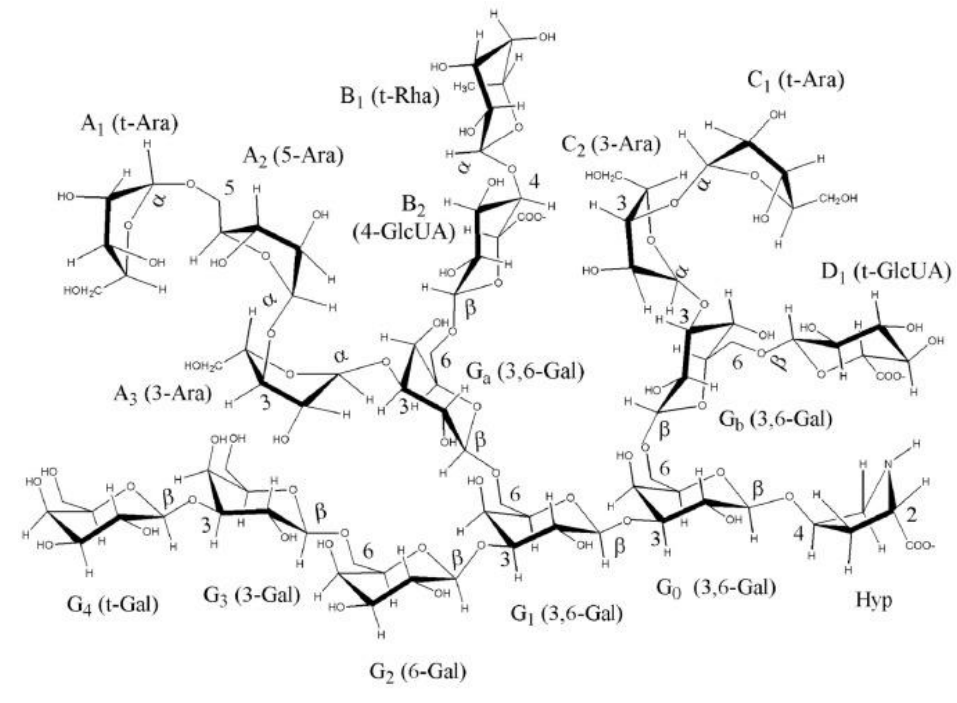
Figure 1. Fragment of AG macromolecule [18]